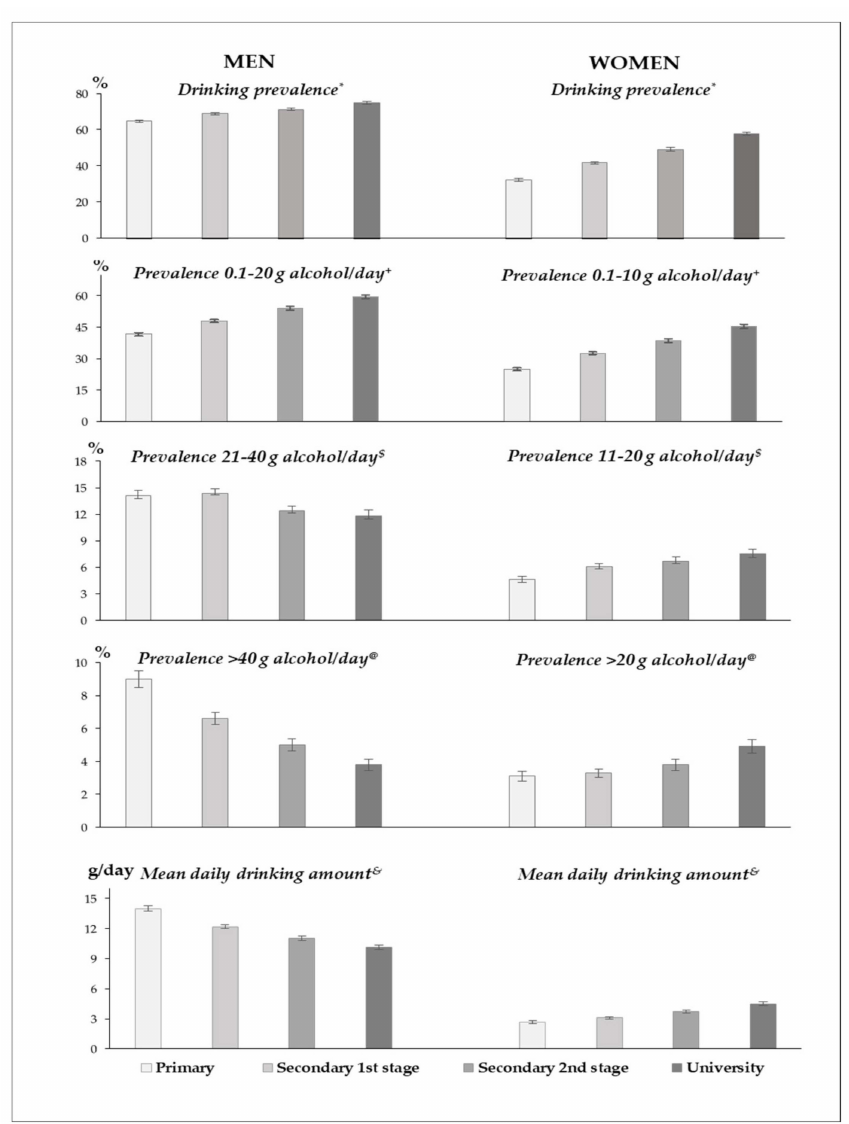
Figure 1. Age-standardized measures of amount of alcohol intake among population aged 25–64 by sex and education level, Spain 1997–2017. Legend : Values were directly standardized using the 2013 Euro- pean Standard Population weights. * Linear trends across education levels were significant both among men ( β = 0.05, p < 0.001) and women ( β = 0.18, p < 0.001). + Linear trends across education levels were significant both among men ( β = 0.12, p < 0.001) and women ( β = 0.19, p < 0.001). $ Linear trends across education levels were significant both among men ( β = − 0.08, p < 0.001) and women ( β = 0.14, p < 0.001). @ Linear trends across education levels were significant both among men ( β = − 0.31, p < 0.001) and women ( β = 0.16, p < 0.001). & Linear trends across education levels were significant both among men ( β = − 0.11, p < 0.001) and women ( β = 0.17, p <